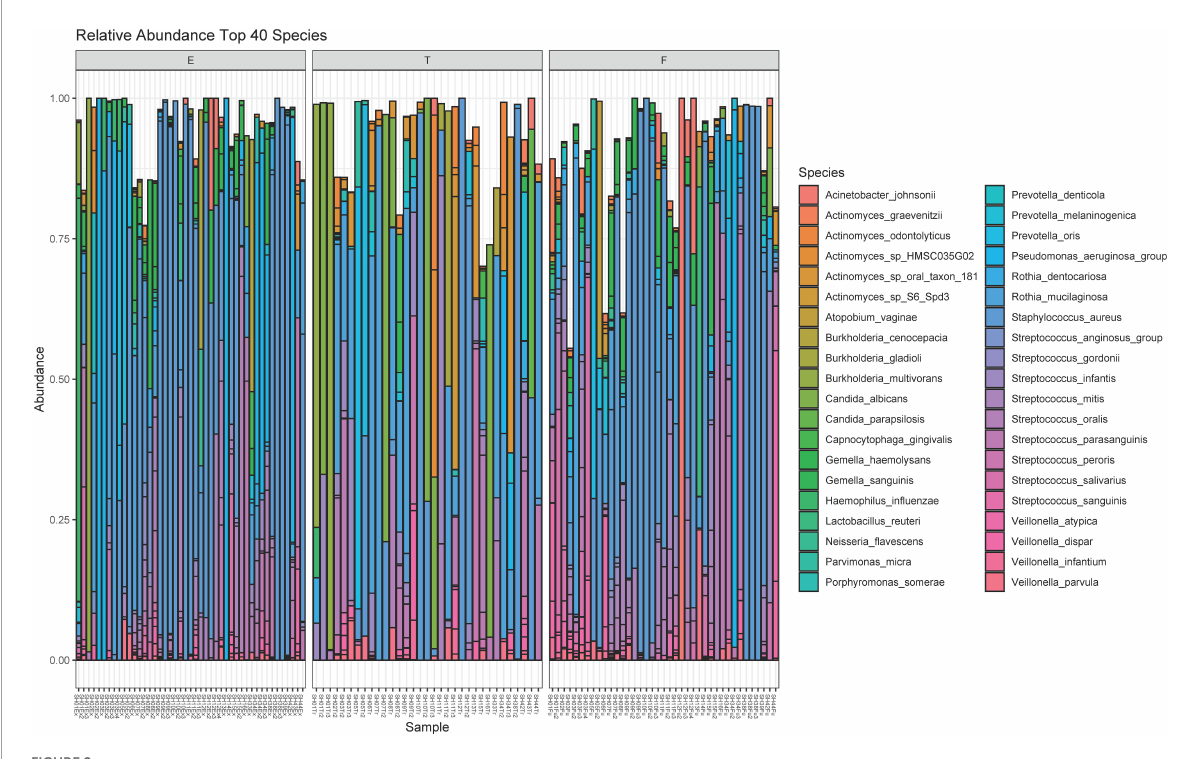
FIGURE2 Relative abundance plot of the top 40 species observed. The 40 species with the highest contribution to the dataset are included here. The bar plot for each sample can approach a maximum relative abundance of 1.00. In cases where the bar is < 1.00, it is because the remaining species contributing to that respiratory sample’s community are from the remaining 181 species observed in the dataset. E, pulmonary exacerbation; T, end of treatment; F, follow up.